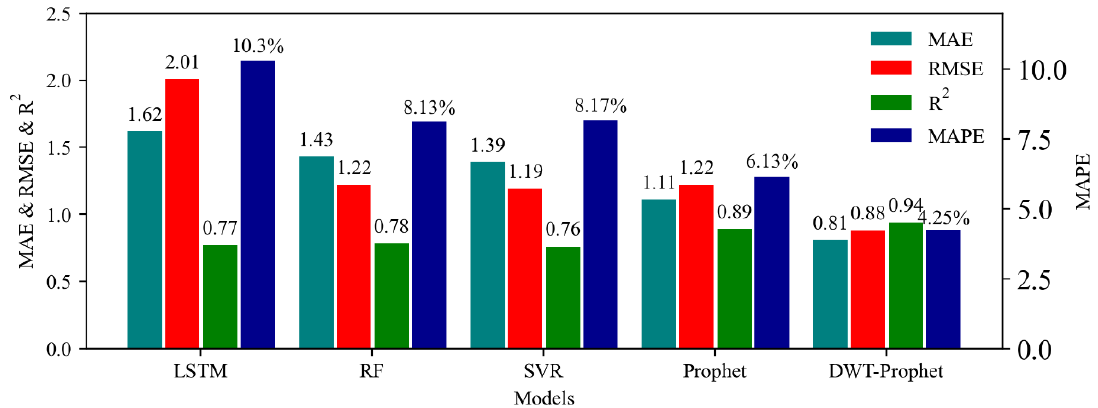
Figure 13. Comparison of the prediction errors for the different methods.